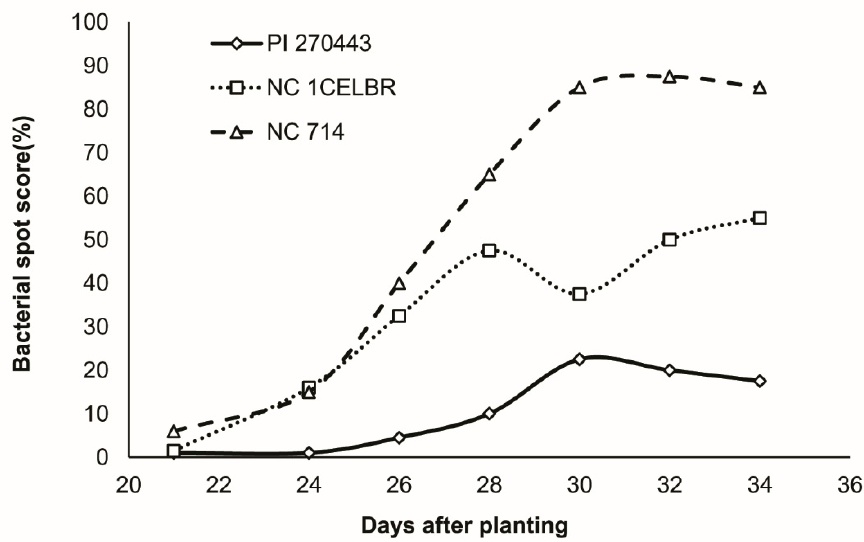
Figure 1. The resistance level of three selected tomato lines for BS.